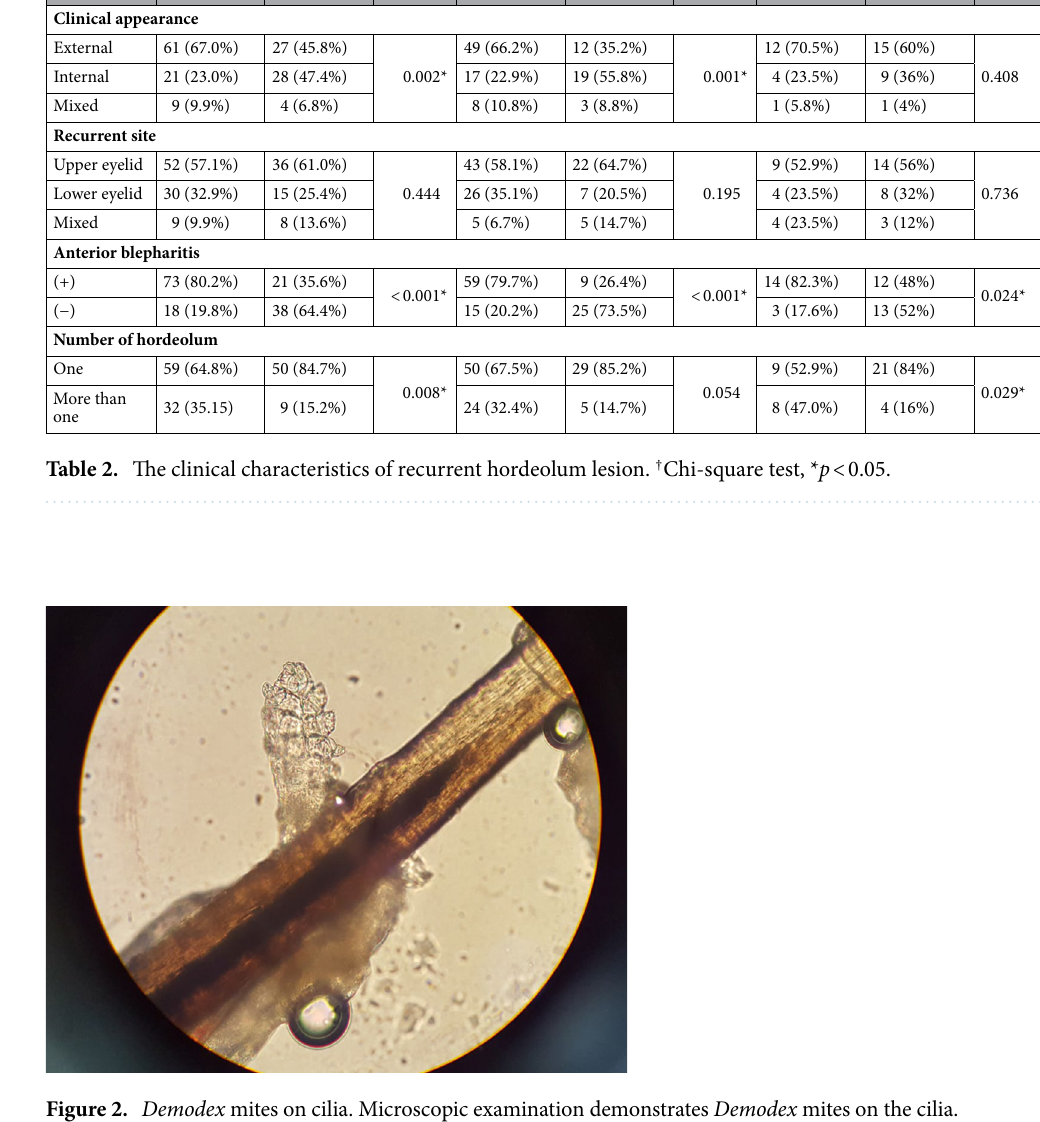
Figure 2. Demodex mites on cilia. Microscopic examination demonstrates Demodex mites on the